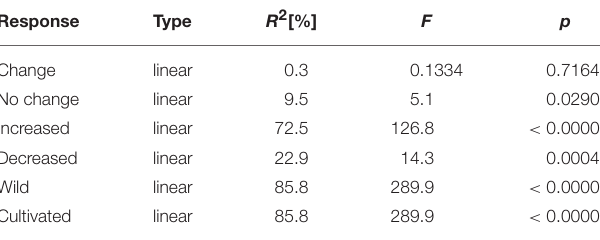
TABLE 5 | Summary of fitted Generalized Linear Models 6 response